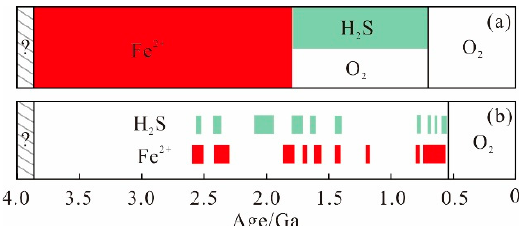
Figure 5. Evolution of Earth’s marine conditions through time (modified after [126]). ( a ). Classical models of the chemical composition of the deep ocean. ( b ) Distribution of Precambrian euxinic and ferruginous deep waters, based on the shale record.